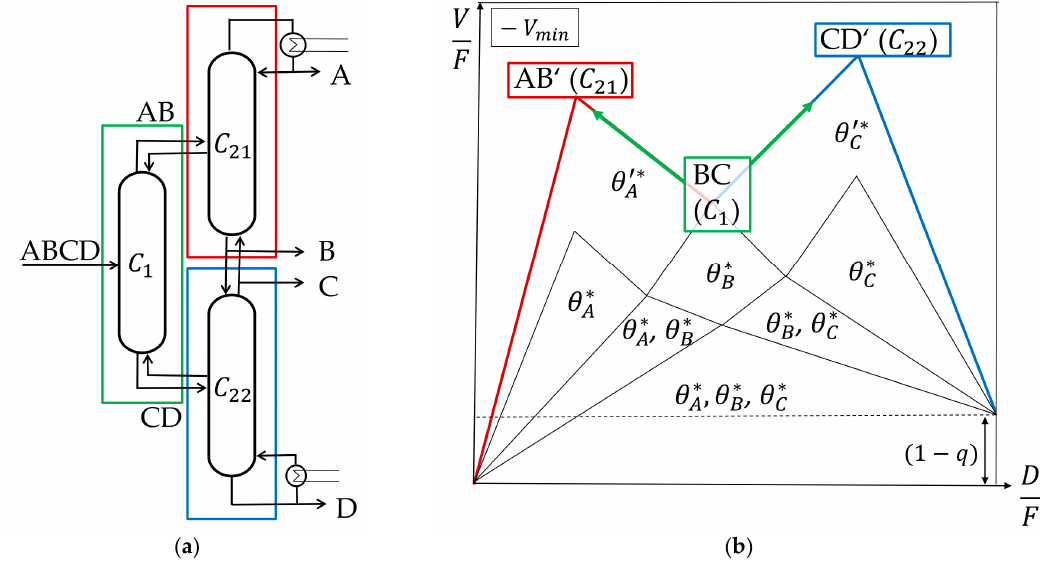
Figure 7. ( a ) Kaibel configuration for four component split and ( b ) corresponding V min diagram. Red lines indicate the new AB split and blue lines the new CD split (modified after [10]).